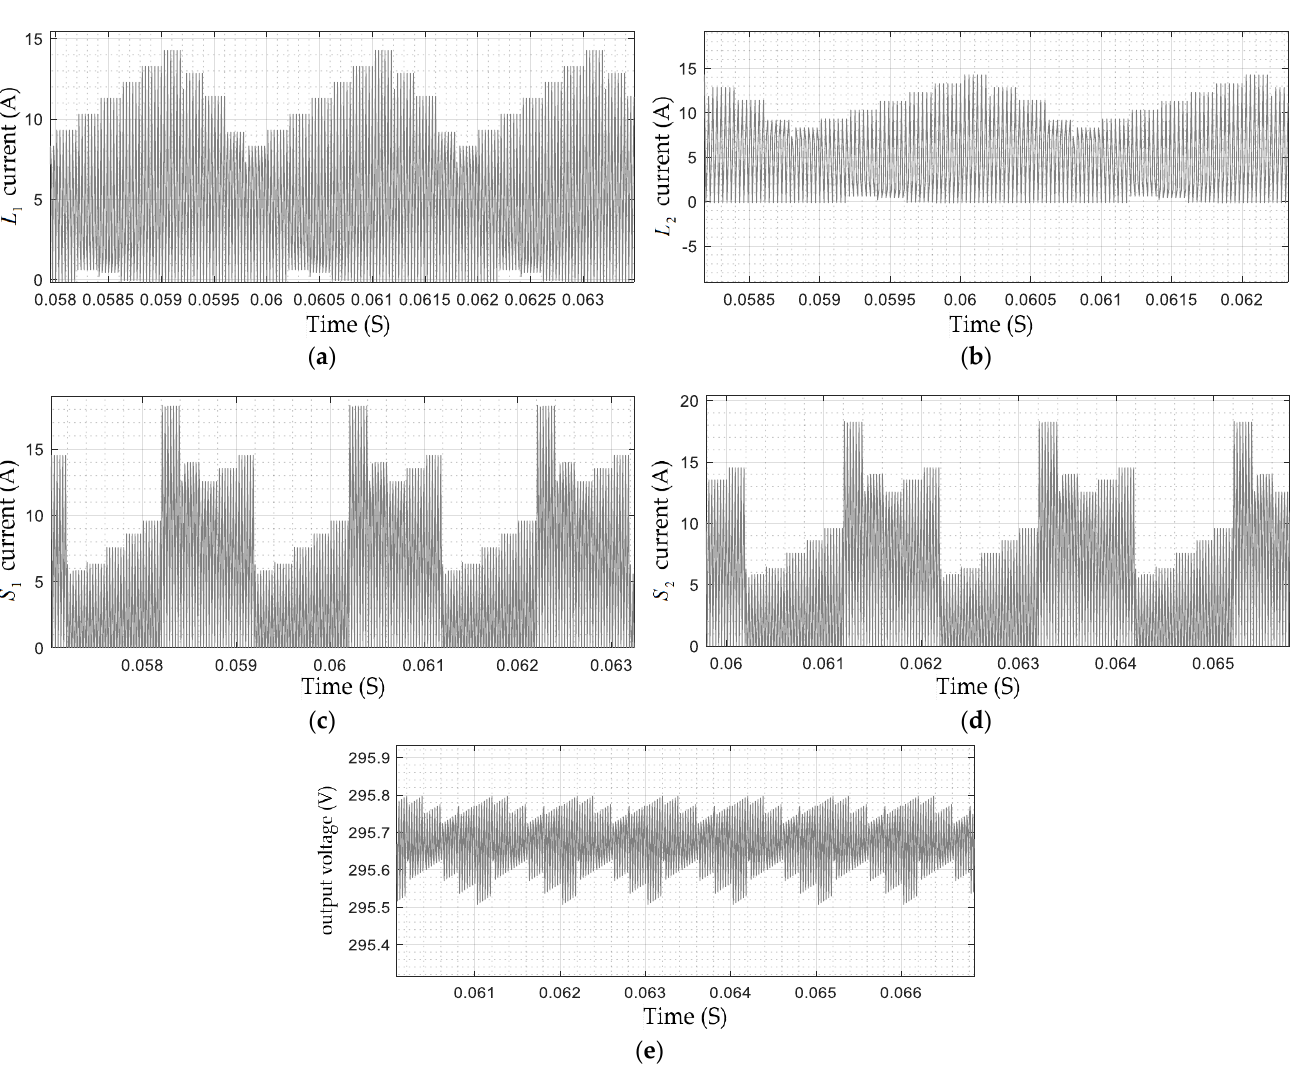
Figure 10. The results in DCM, ( a ) L 1 current, ( b ) L 2 current, ( c ) S 1 current, ( d ) S 2 current, and ( e ) output